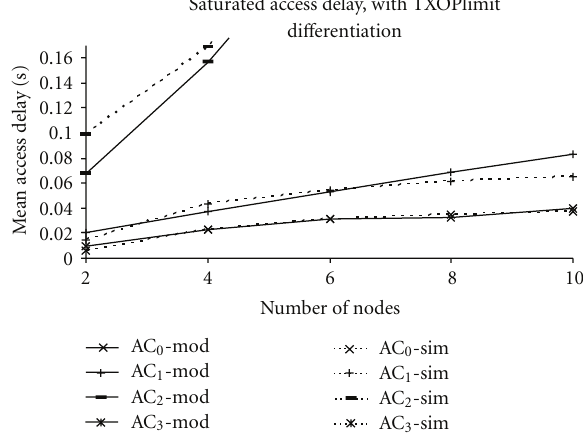
Figure 17: Throughput per AC, with TXOP.